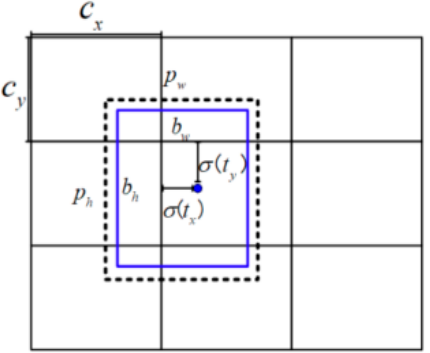
Figure 3. Bounding box prediction of the target.